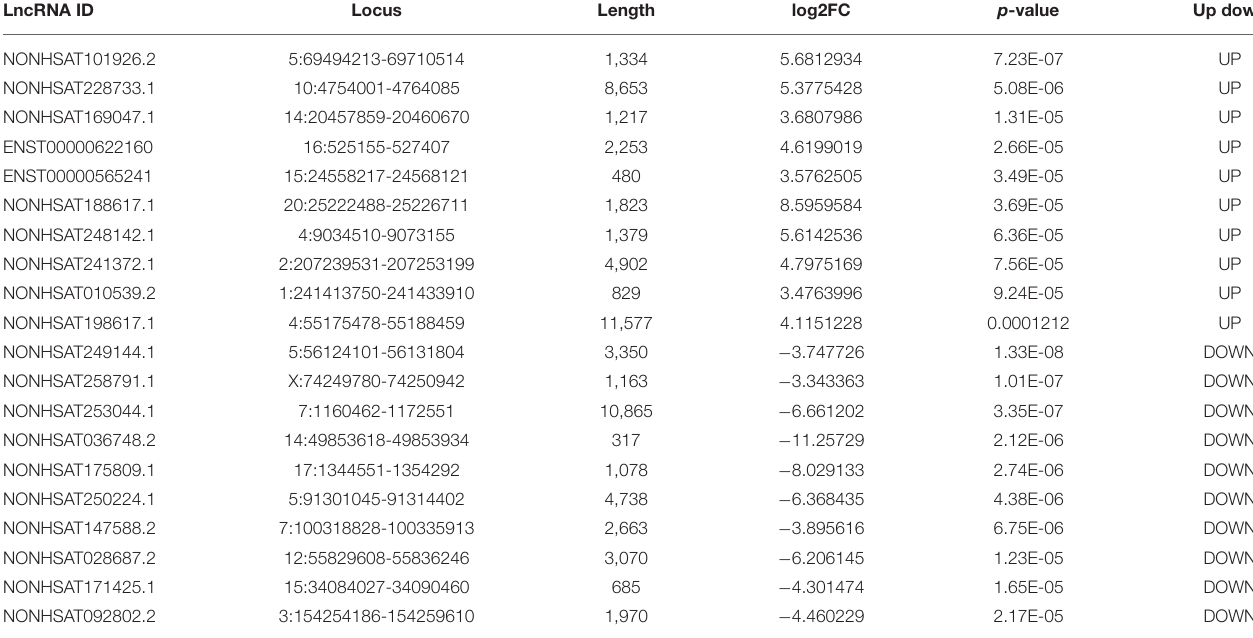
TABLE 4 | The ten most upregulated and ten most downregulated lncRNAs. LncRNA ID